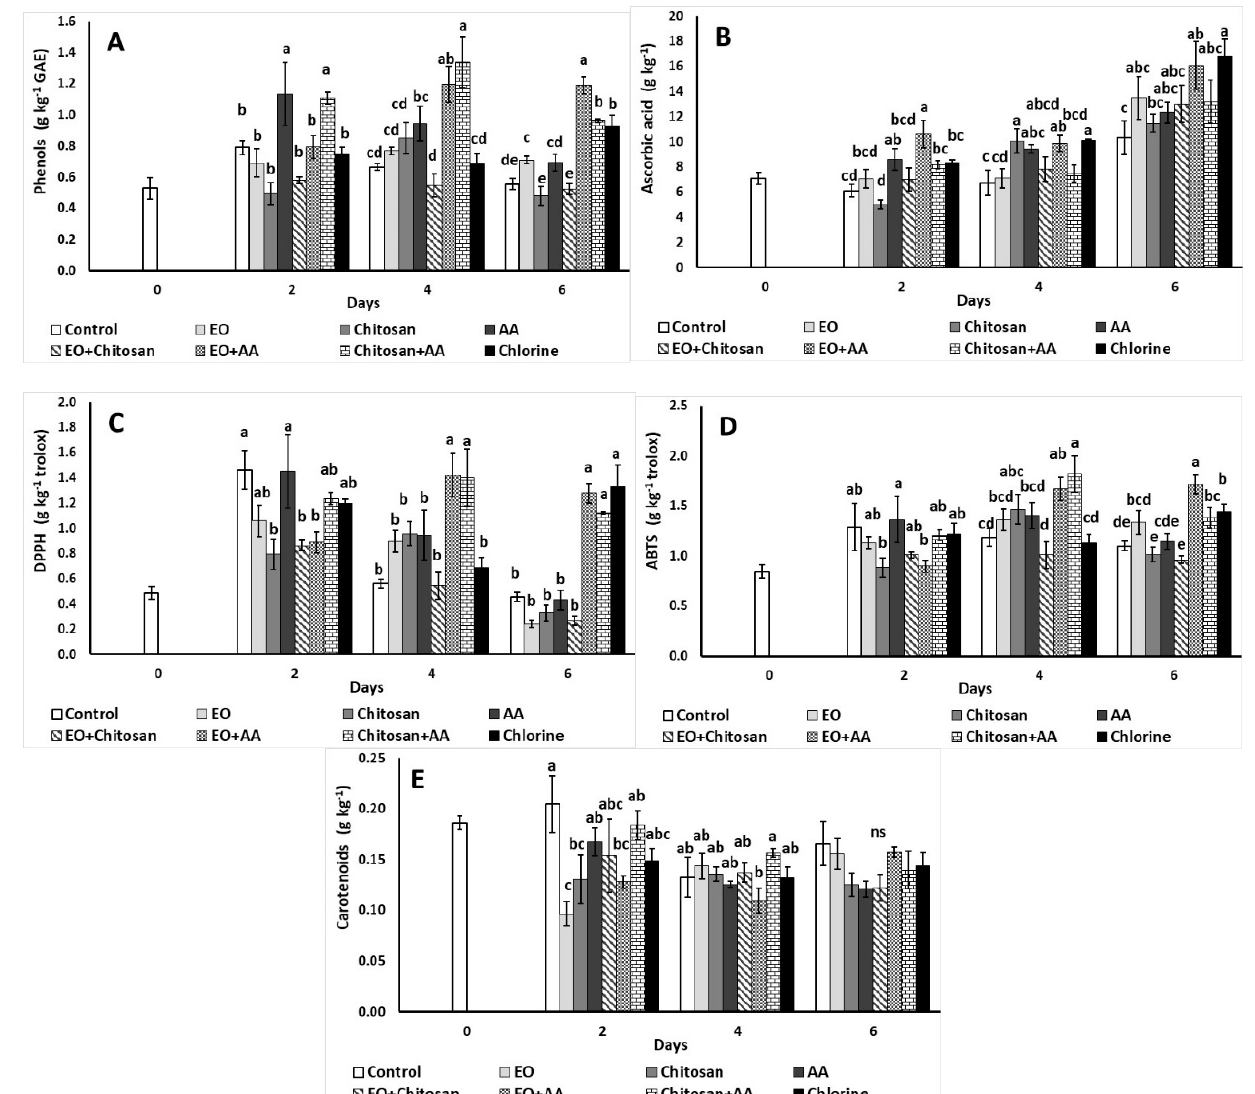
Figure 6. Effect of marjoram essential oil (EO), chitosan and ascorbic acid (AA) on fresh-cut lettuce ( A ) total phenolics (g kg − 1 GAE), ( B ) ascorbic acid (g kg − 1 ), ( C ) antioxidant activity (DPPH; g kg − 1 trolox), ( D ) antioxidant activity (ABTS; g kg − 1 trolox), and ( E ) carotenoids (g kg − 1 ) content after treatment and 6 days of storage at 7 °C and 90% RH. On the columns, significant differences ( p < 0.05) among treatments are indicated by different Latin letters; ns indicates no significant differences for different days. Values represent means (±SE) of measurements made on three biological replicates per treatment.